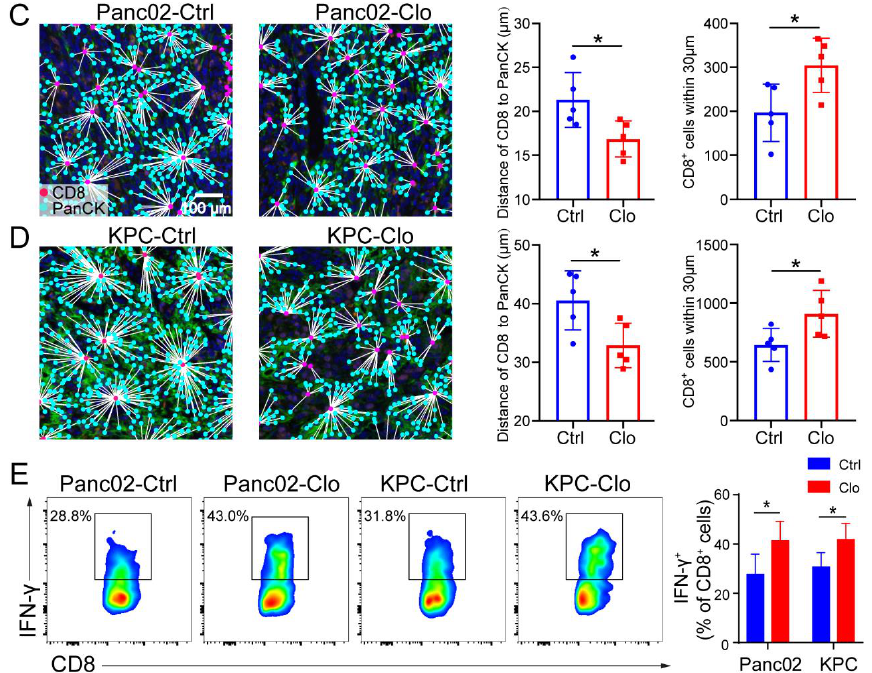
Figure 6. Targeting macrophages promoted CD8 + T cell spatial redistribution in tumors. Panc02 and KPC murine pancreatic tumor cells were subcutaneously injected into C57BL/6 mice, and the effects of treatment with control liposomes or clodronate liposomes on intratumoral T cell infiltration and spatial redistribution after macrophage targeting were evaluated. ( A , B ) Representative images of the edge (periphery) and center (core) of the tumor sections after anti-CD8 immunostaining are shown. For each tumor, the numbers of CD8 + T cells at the edge of the tumor ( ≤ 500 µ m from the edge of the tumor) and the tumor center (>500 µ m from the edge of the tumor) were quantified. The distance between the nuclear centers of a PanCK + tumor cells and their nearest CD8 + T cells was calculated for each PanCK + cell identified within the tumor center. ( C , D ) The average distances of CD8 + T cells to tumor cells in all tumor samples were calculated. ( C , D ) ( right ) The distribution of CD8 + T cells within 30 µ m from tumor cells. Each group contained five mice, corresponding to the five points in the bar graph. We analyzed at least five views for each point and calculated the average density of cells at the center and edge to represent each slide. ( E ) Representative flow cytometric analysis of IFN- γ + CD8 + cells in CD8 + T cells and a statistical graph are shown. Data are shown as the mean ± SEM. Statistical analyses were carried out by Student’s t test. *: p ≤ 0.05, **: p ≤ 0.01, ***: p ≤ 0.001, ns: not significant ( p >